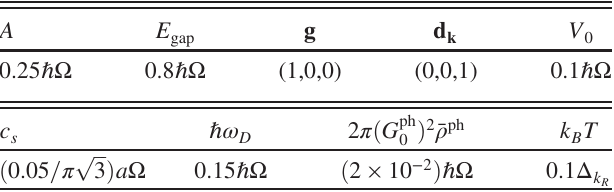
ratio 2 π ð G ph 0 Þ 2 ¯ ρ ph = ð ℏ Ω Þ ,where ¯ ρ ph